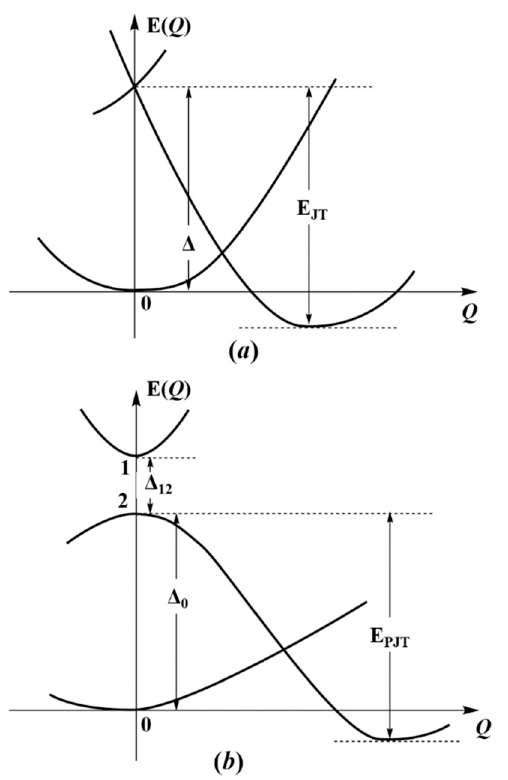
Figure 1. Illustration to the origin of h -JTE and h -PJTE. In both cases the distortion of the system in the ground state global minimum of the APES is due to the JTE ( a ), or PJTE ( b ) in the excited state; it takes place when their stabilization energy (respectively, E JT or E PJT ) is larger than the energy gap to the ground state of the high-symmetry configuration ( Δ and Δ 0 , respectively); Δ 12 is the energy gap between the two excited states producing the h- PJTE.